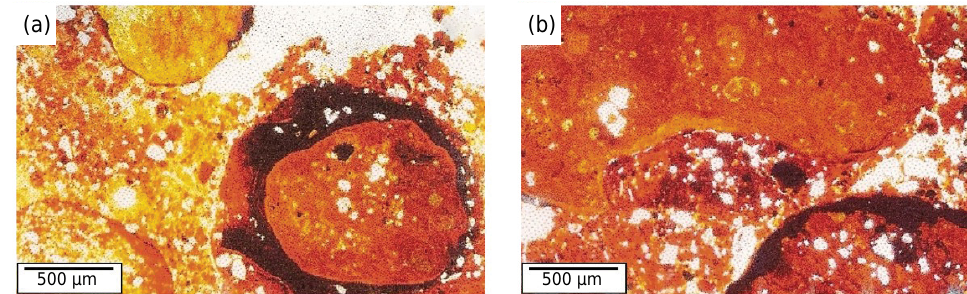
Figure 11. Photomicrographs of the Bw 2 horizon in the P 7 - Geric Rhodic Petroplinthic Ferralsol (Clayic, Dystric); Coromandel topolithosequence. Ferruginous concretions including quartz grains, and with ferrans formed either by hematite or by goethite (a and